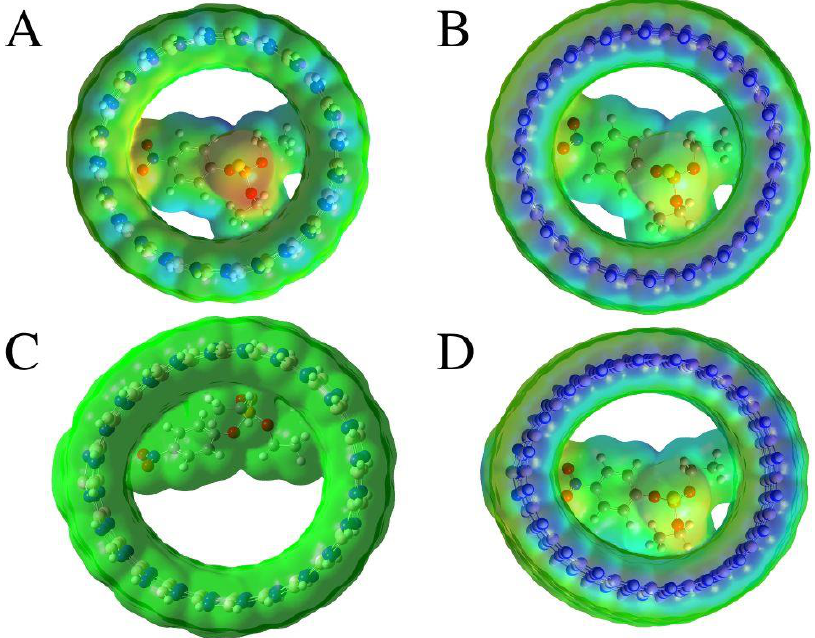
Figure 1. Electrostatic potentials of ( A ) BNNT(12,12) + par, ( B ) BNNT(20,0) + par, ( C ) Al-BNNT(12,12) + par, and ( D ) Al-BNNT(20,0) + par.